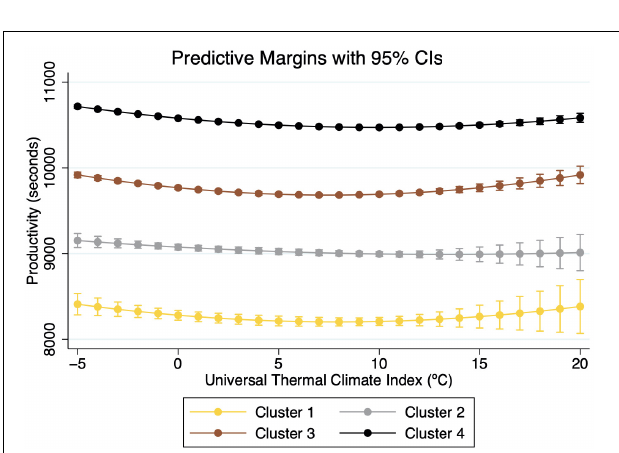
FIGURE 3 | Marginal Impact of UTCI on performance by